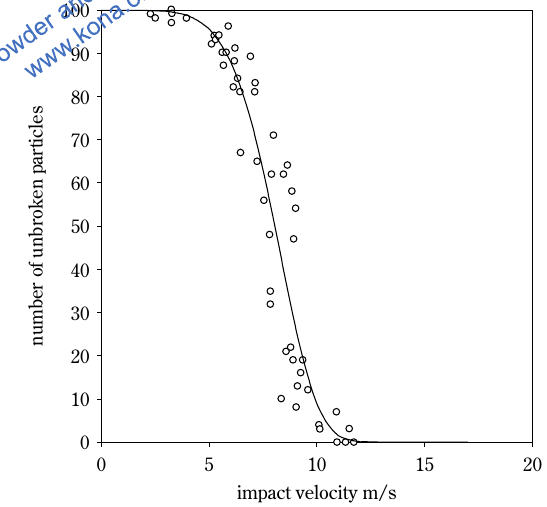
Fig. 5 Typical relationship between particle impact velocity and number of unbroken particles (7-mm diameter spherical fertiliser particles under normal impact)